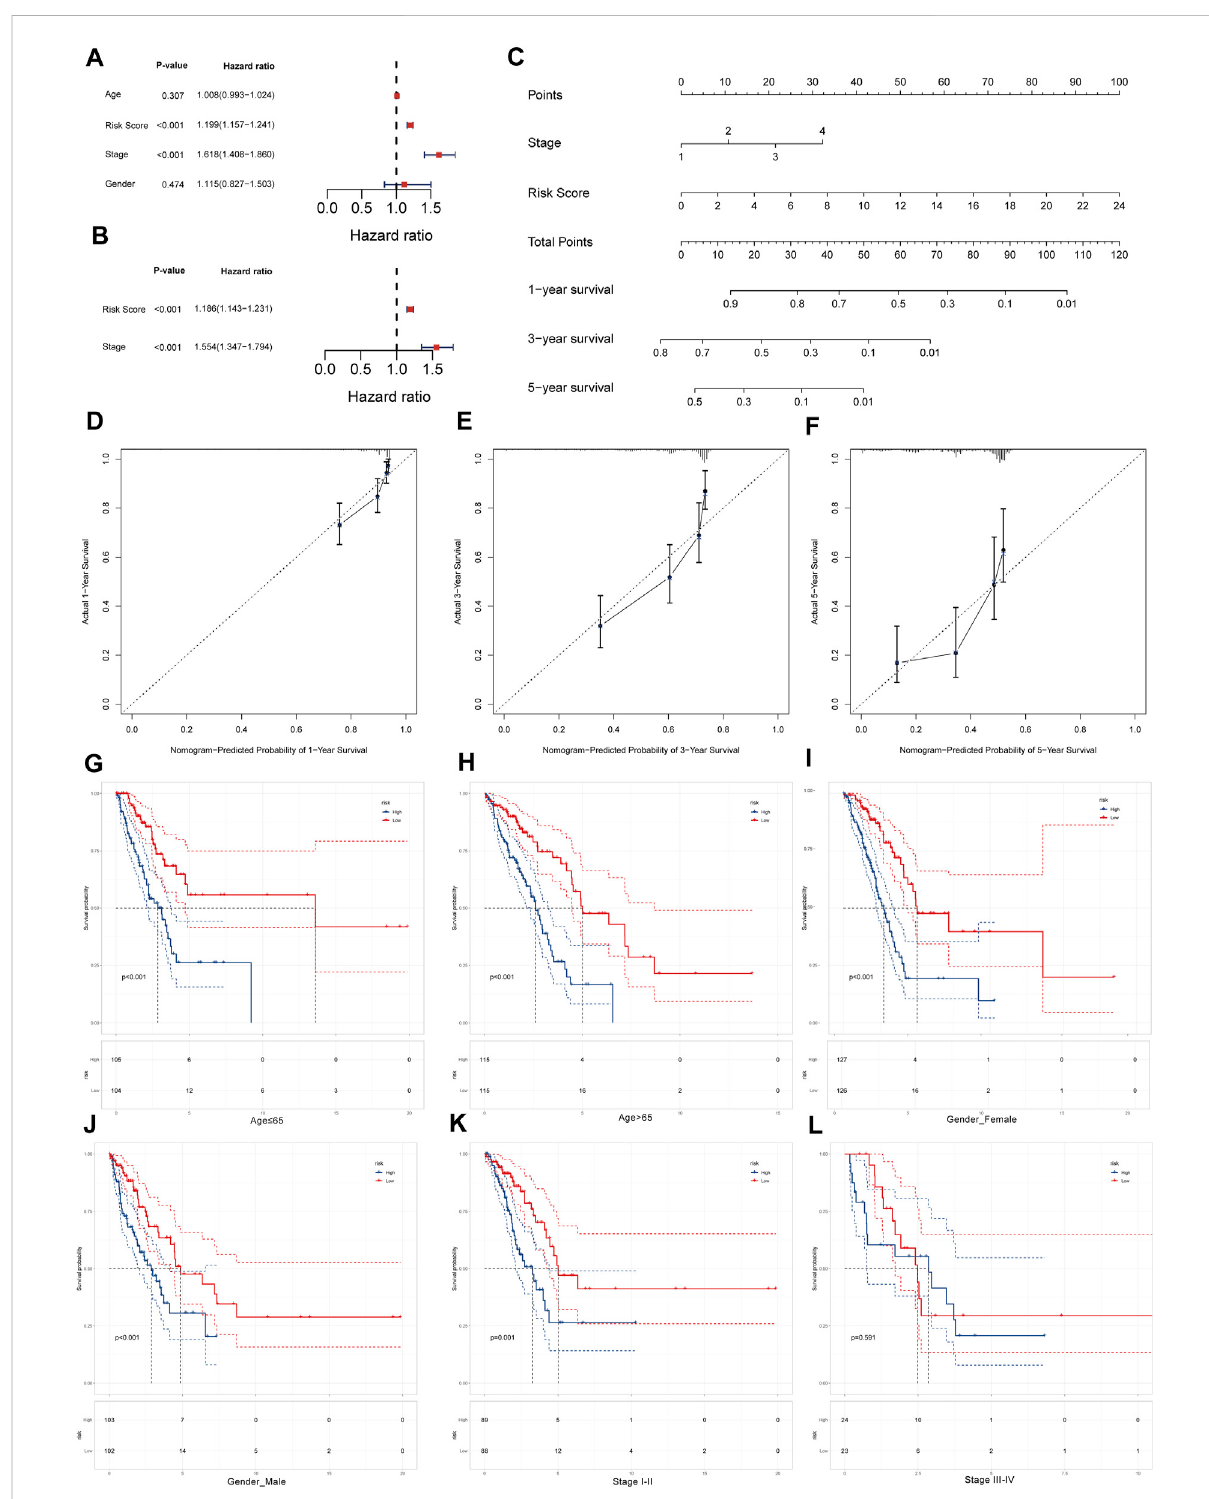
FIGURE 5 Survival prediction ability of LRPI and strati fi ed survival analysis of two LRPI subgroups (A and B) Univariate and multivariate cox analysis to validate the independent prognostic power of LRPI (C) The nomogram was established by clinical stage and LRPI to predict the survival rate of patients at 1, 3, and 5 years (D – F) The calibration plot of nomogram at 1, 3, and 5 years (G and H) Age-strati fi ed K-M survival curve analysis of two subgroups of LRPI, age was divided into two groups ≤ 65 and > 65 (I and J) Gender-strati fi ed K-M survival curve analysis of two subgroups of LRPI,genderisdivided intofemaleandmaletwogroups (KandL) Stage-strati fi edK-Msurvivalcurveanalysis oftwosubgroupsofLRPI, clinicalstage was divided into two groups, I-II and